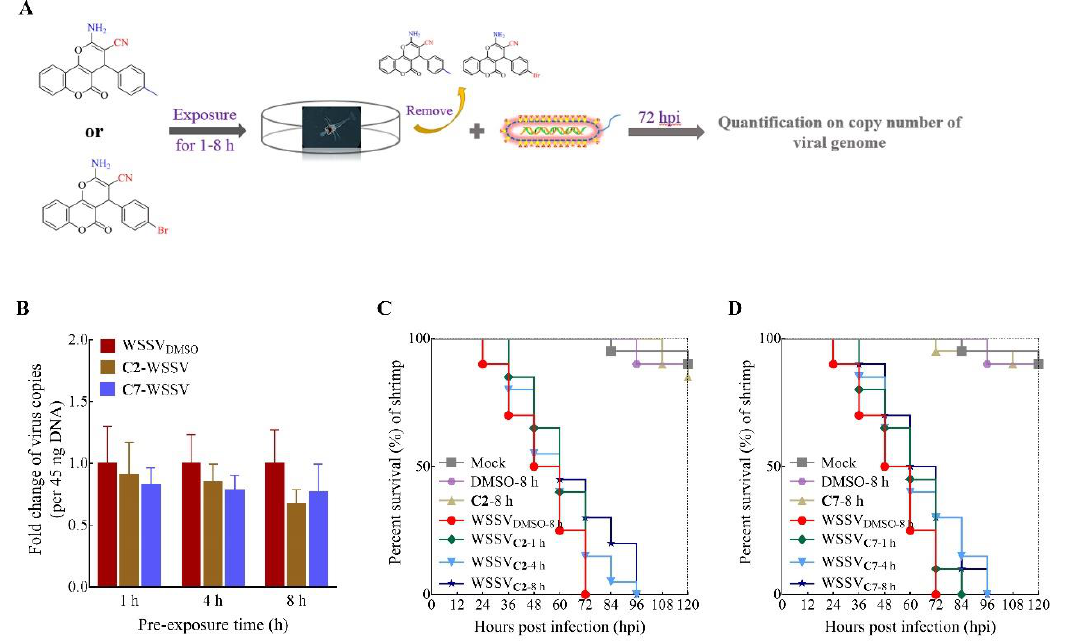
Figure 3. Effect of C2 and C7 pre-exposure was evaluated on WSSV infection. ( A ) Schematic diagram describing the work- flow. ( B ) Quantification on copy number of viral genome in shrimp larvae was tested in C2 and C7 pre-exposure to larvae for 1, 4, and 8 h, followed by WSSV infection. ( C , D ) Survivorship curve of WSSV-infected shrimp was analyzed in C2 and C7 up to 10 mg/L pre-exposure treatment. Each value is represented as the mean ± SD normalized to values for no treat- ment. The p value for each study was determined by Student’s t tests.